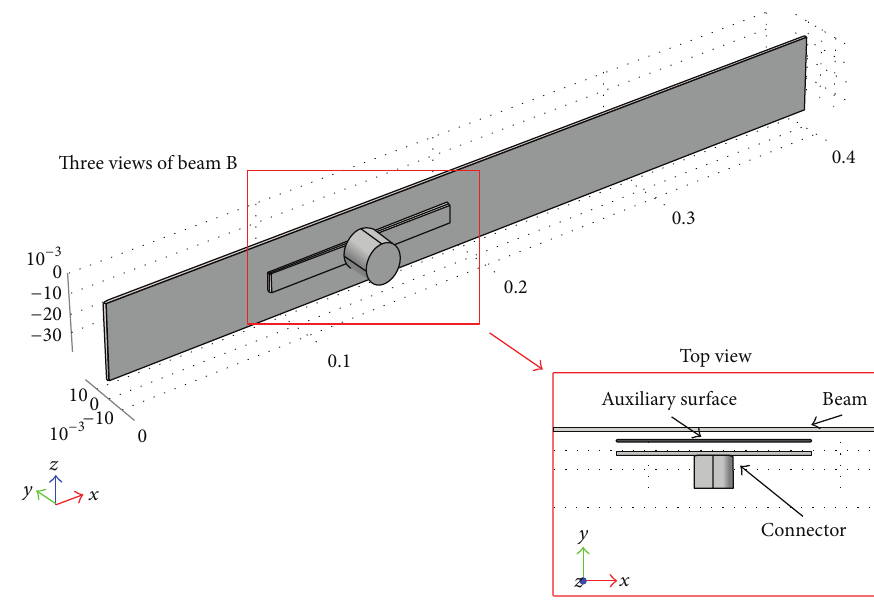
Figure 8: The geometry model of beam B. Table 3: Natural frequency differences of beam B under a hammer impact before and after model updating.